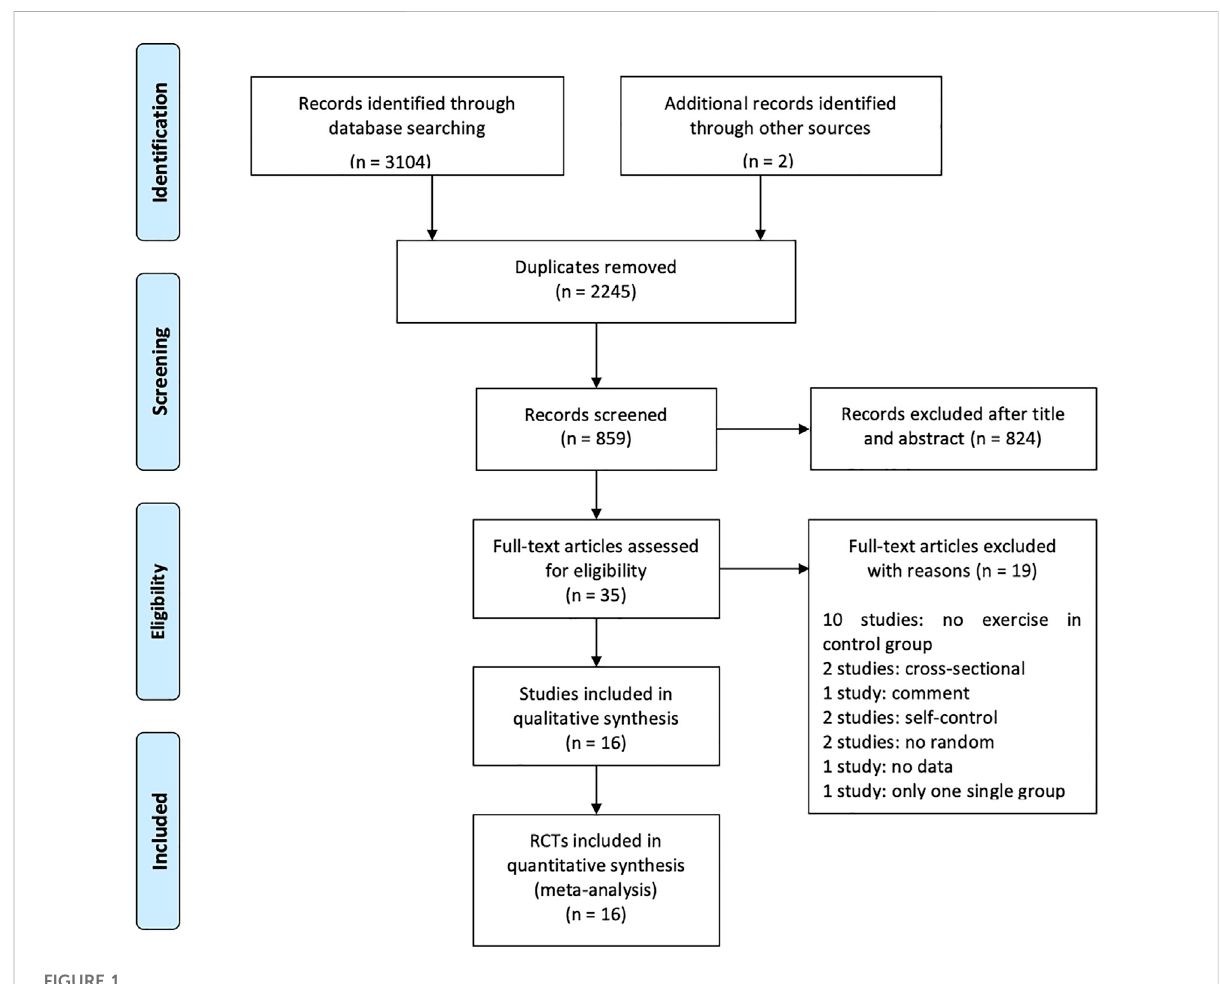
FIGURE 1 PRISMA fl ow